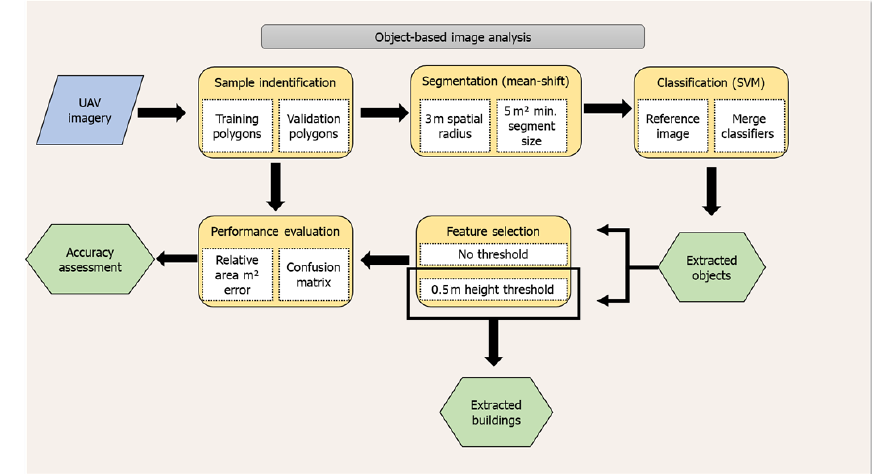
Figure 6. Conceptual model of the building classification using automatic extraction methods. Table 3. Samples used as input for training the SVM classifier with mean value ranges of the spectral bands (nm). Value Label